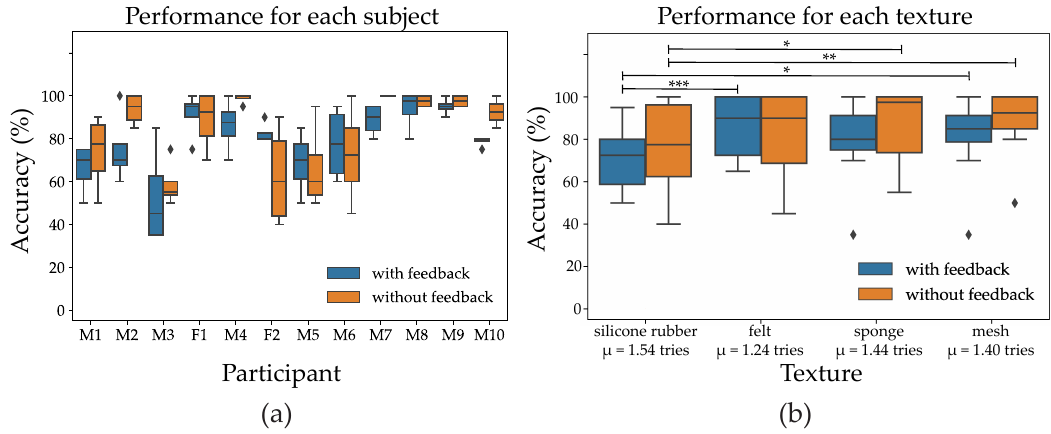
Figure 4. ( a ) The median accuracy for each participant where three participants were over 90% during the first phase (with feedback) and six participants during the second phase (without feedback). ( b ) The box plot shows the performance of the 12 participants on each texture. The x-axis also shows the average attempt the participants had for each texture.